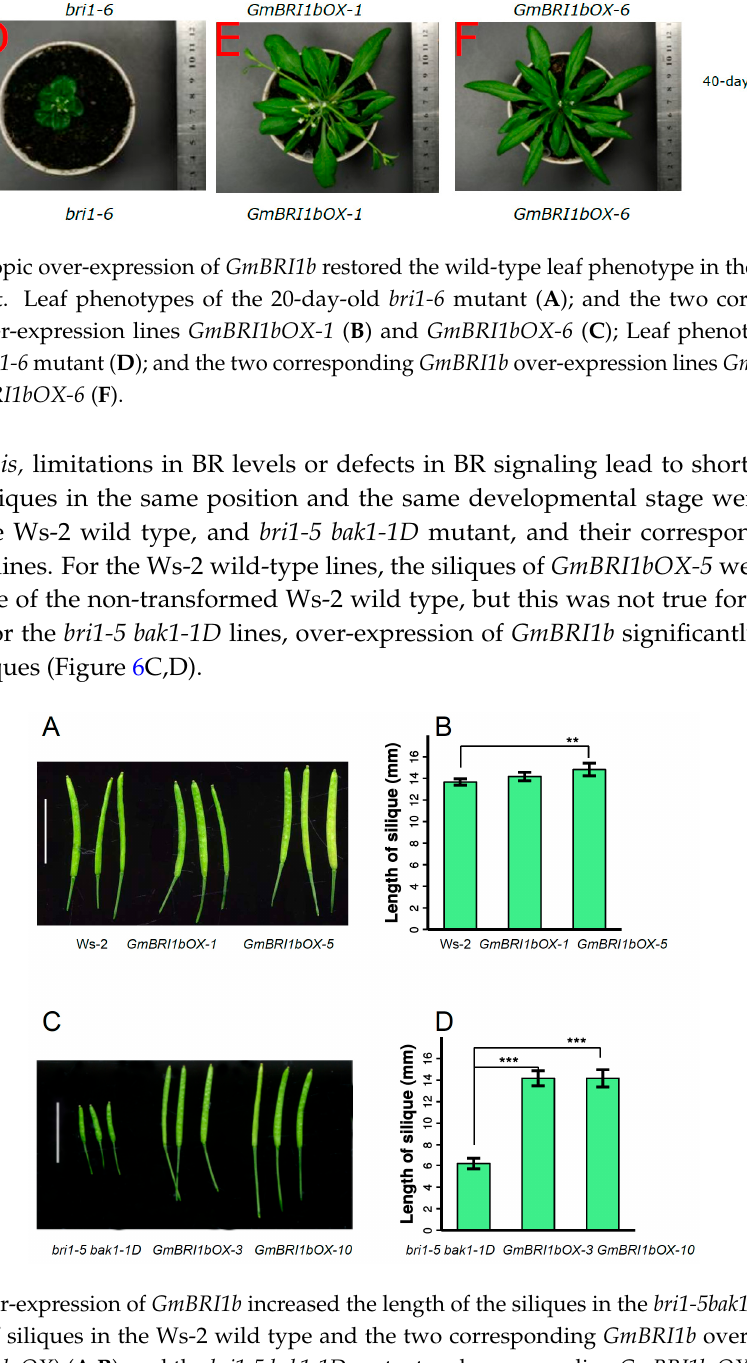
Figure 6. Over-expression of GmBRI1b increased the length of the siliques in the bri1-5bak1-1D mutant. The length of siliques in the Ws-2 wild type and the two corresponding GmBRI1b over-expression lines ( GmBRI1b-OX ) ( A , B ); and the bri1-5 bak1-1D mutant and corresponding GmBRI1b-OX lines measured) (Student’s t -test, ** p < 0.01, *** p < 0.001). Scale bar = 1 cm.